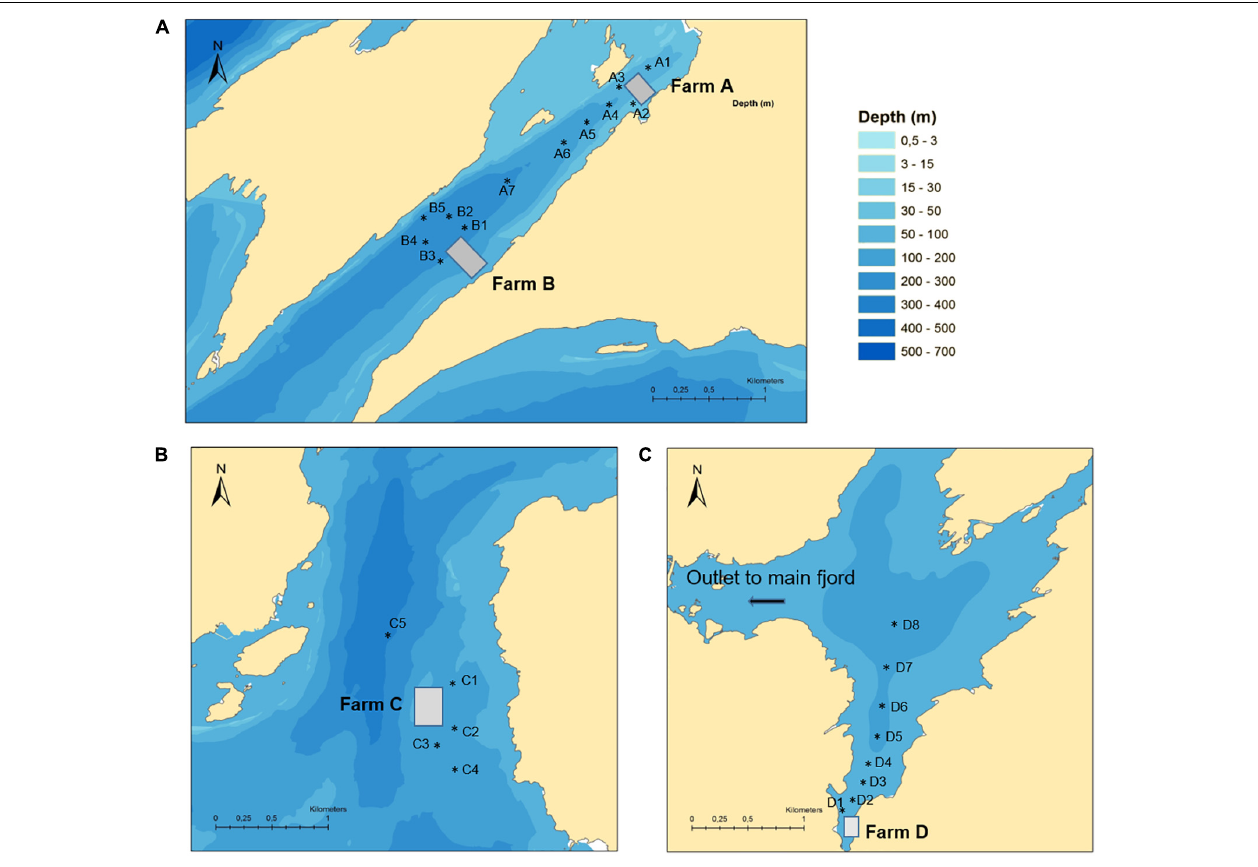
FIGURE 1 | Locations of the four farms in a Norwegian fjord situated along the west coast. Farm A and Farm B are shown in panel (A) , Farm C is shown in panel (B) and Farm D is shown in panel (C) .